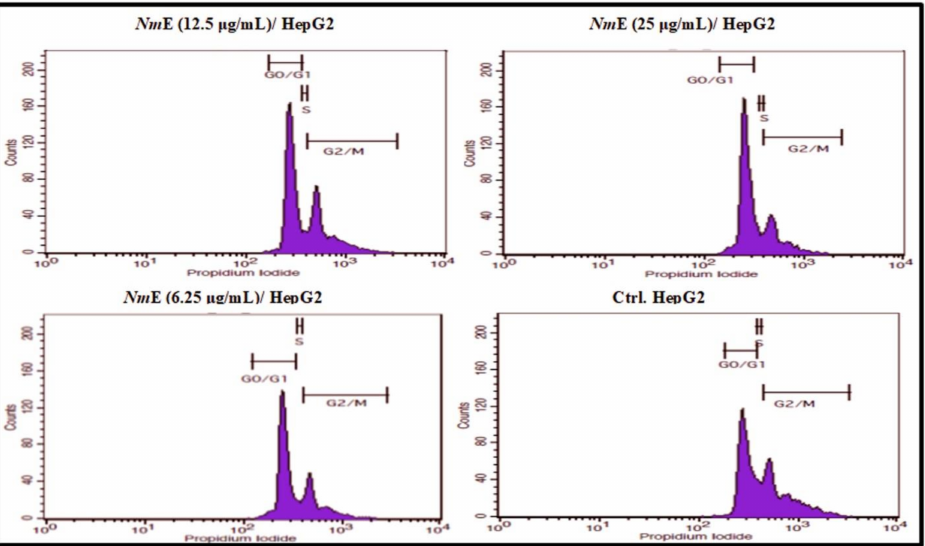
Figure 9. Cell cycle analysis of HepG2 cell line treated with Nm E.